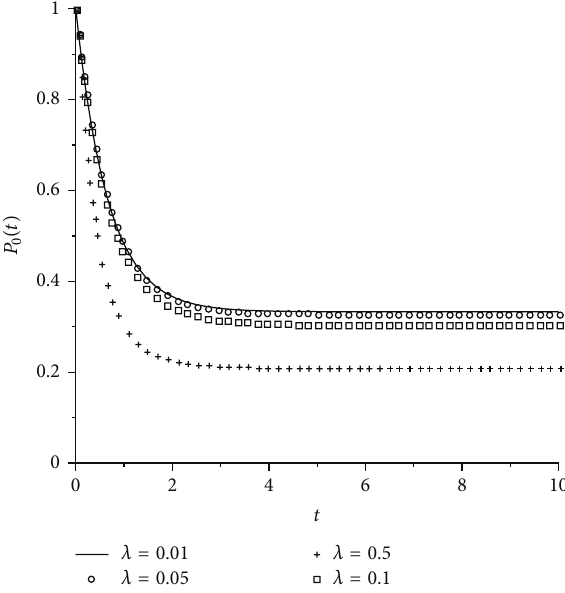
Figure 1: Instantaneous probabilities of the system without warning device in good state with different 𝜆 .